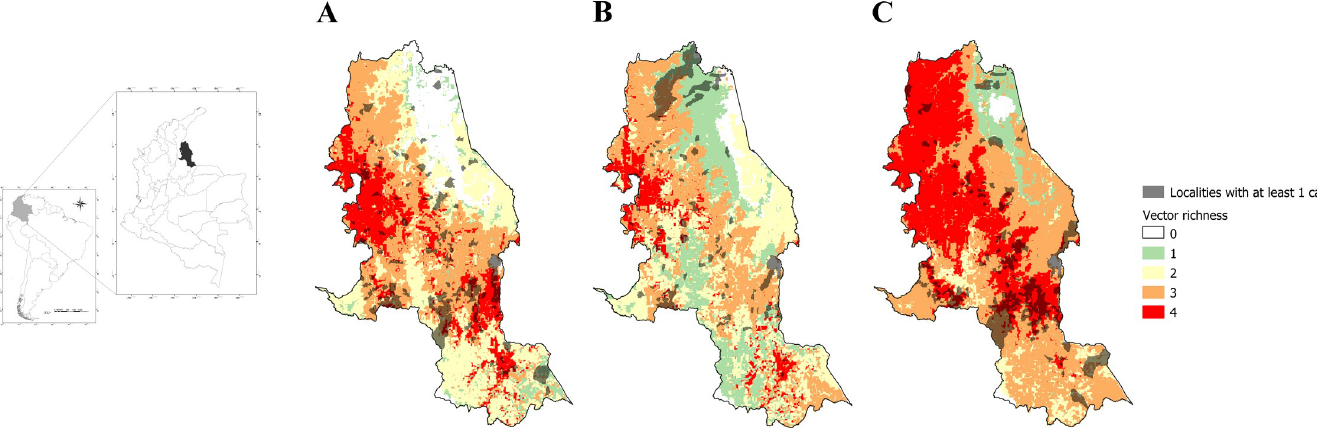
Fig 7. Intersection of rural localities in Norte de Santander with at least one CL case and potential richness of vectors during episodes. (A) Neutral 2012–2015 episode. (B) La Ni ñ a 2010–2011 episode. (C) El Ni ñ o 2015–2016 episode. The information was supplied from Laboratorio de Salud Pu´blica of Norte de Santander. Maps were done using QGis